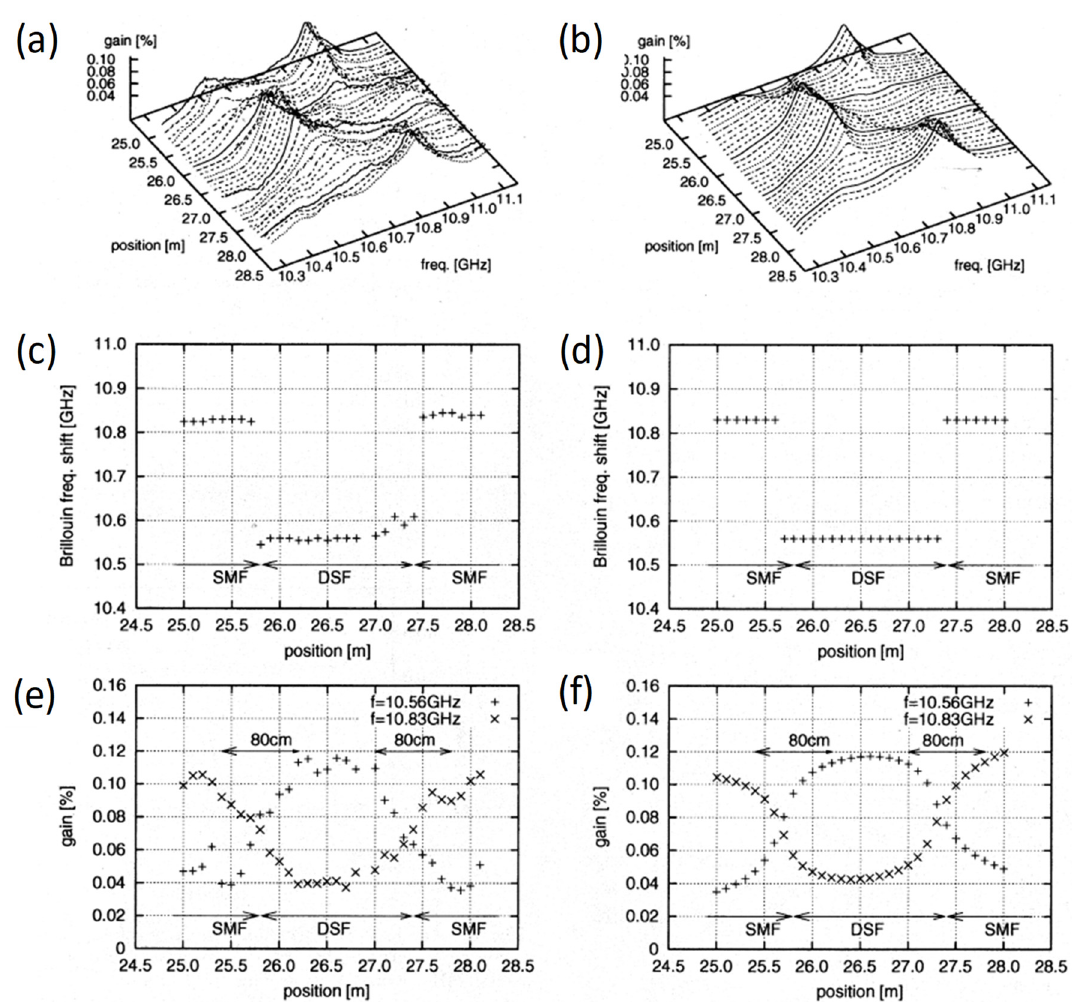
Figure 20. Experimental results and simulation results of the BOCDA outputs [8]. ( a , c , e ) are for the experiments, and ( b , d , f ) are for the simulation; ( a , b ) show the BGS distribution; ( c , d ) show the Brillouin frequency shift (BFS) distribution; ( e , f ) show the intensity distributions for the BFS of 10.83 GHz and 10.56 GHz, respectively.